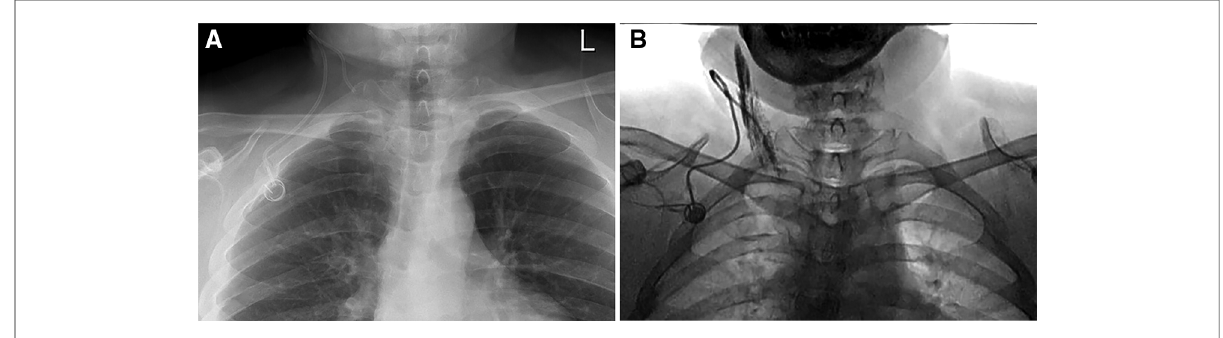
FIGURE 5 The catheter tip is located in the extravascular. ( A ) The catheter tip is seemingly located in the IJV; ( B ) No blood was drawn back from the port, and DSA shows that the contrast medium was over fl owing, indicating that the catheter tip is not in the blood vessel.